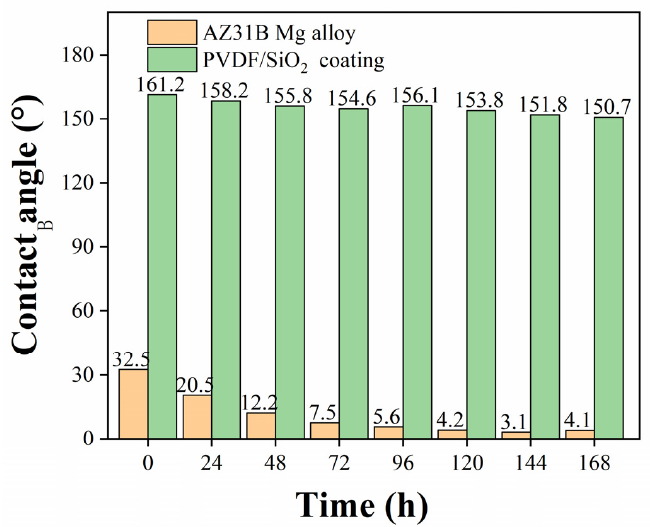
Figure 13. The contact angle after salt spray experiment of superhydrophobic coating.